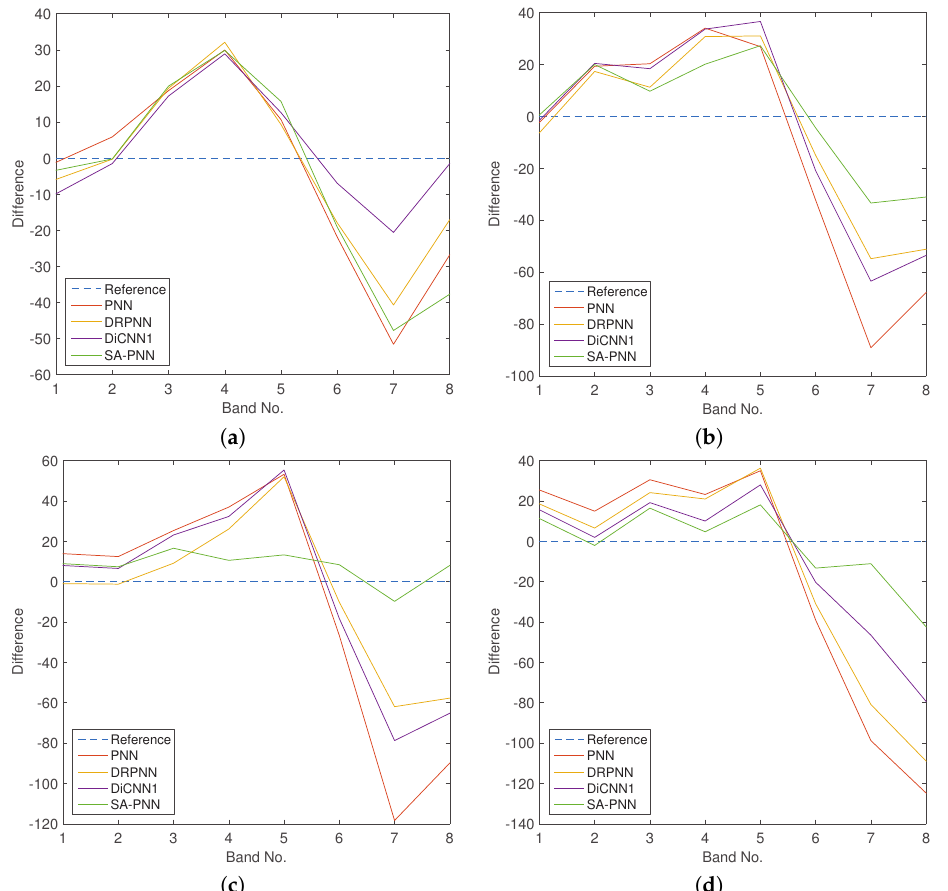
Figure 4. Spectral difference curves between the ground truth and the pansharpening results for the WorldView-2 dataset at randomly selected spatial coordinates: ( a ) (64, 32); ( b ) (53, 169); ( c ) (100, 55); and ( d ) (200, 202), which are marked in Figure 3a with red